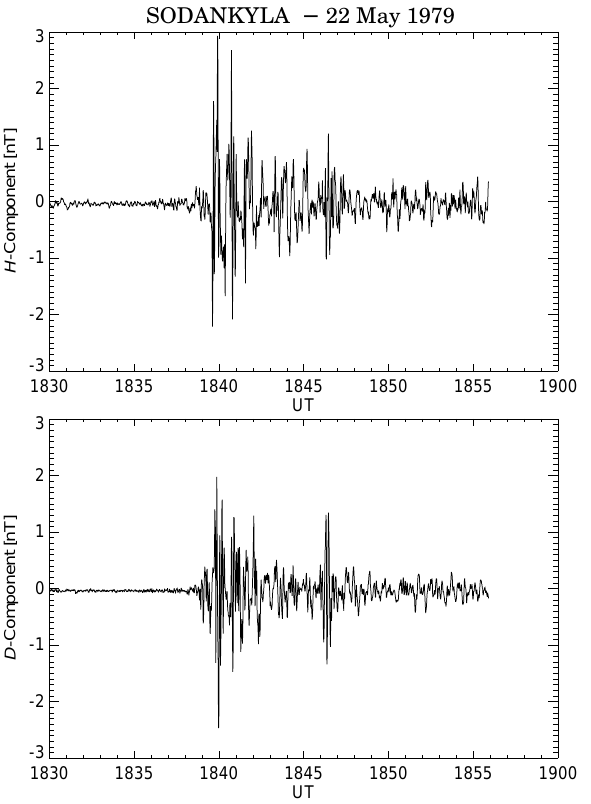
Fig. 5. Ground observations of the magnetic H - and D -components recorded at Sodankyl¨a.